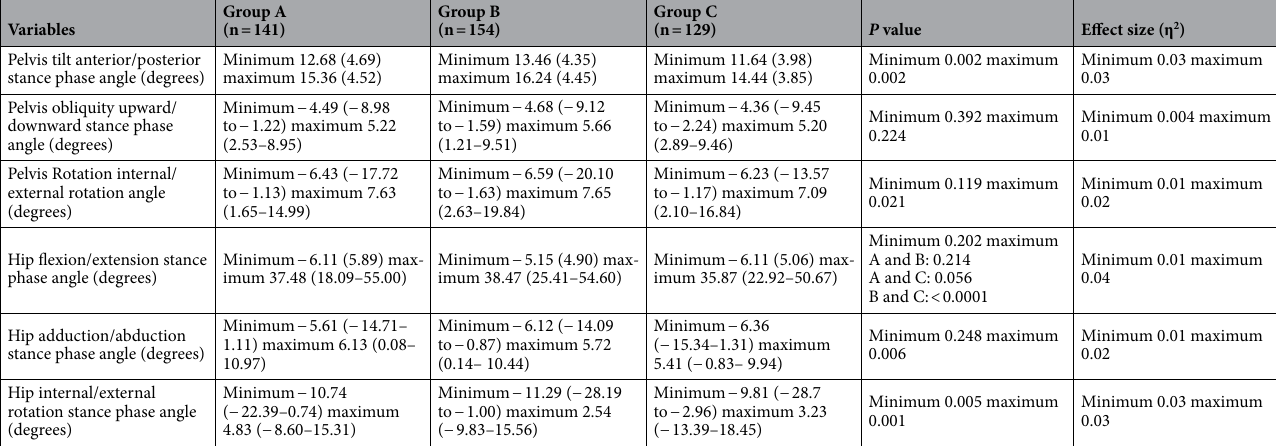
Table 4. The minimum and maximum values for the gait kinematics of the pelvis and hip angle for the three age groups (N = 424). Group A (6–8 years), Group B (9–10 years), Group C (11–12 years). Differences between the three groups were analyzed using the Kruskal–Wallis test or one-way analysis of variance. Variables with significant differences were subsequently compared using multiple comparison analyses with Bonferroni correction. Data are presented as means (standard deviation) or median values (range). P values < 0.0001 were considered statistically